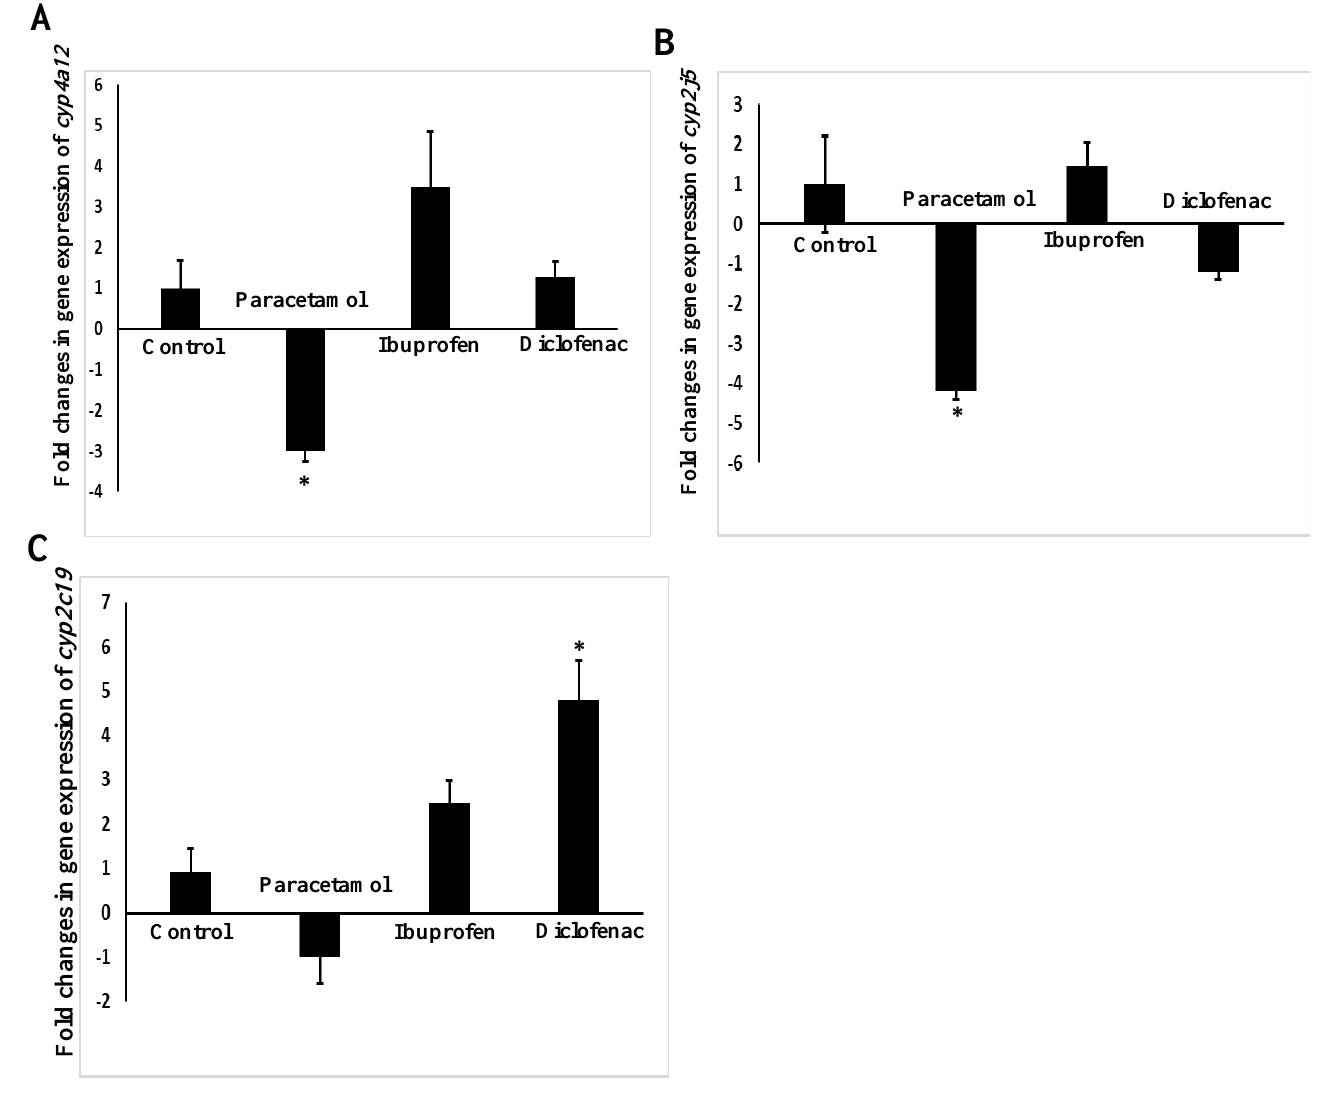
Figure 7. Expressions of cyp4a12 ( A ), cyp2j5 ( B ), and cyp2c29 ( C ) genes in the lungs of NSAID- and paracetamol-treated mice. The target expression was quantified relative to the expression of the actin gene. Fold change is the ratio of mean expression of the NSAID- and paracetamol-treated to the control value; negative values indicate a reduction in fold change; * indicates a statistical difference ( p < 0.05, one-way ANOVA test) in comparison with the control group.